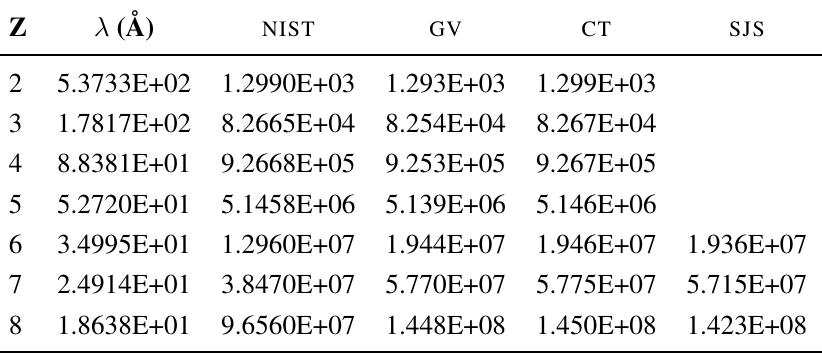
Table 4. Comparison of the A (2 − 10 , 2 , 3 1 D showing the incorrectly assigned data in the NIST database (v5.1) for 6 ≤ Z ≤ 8 . GV: [108] computed with the MCHF method. CT: [112] using explicitly correlated functions. SJS: [121]